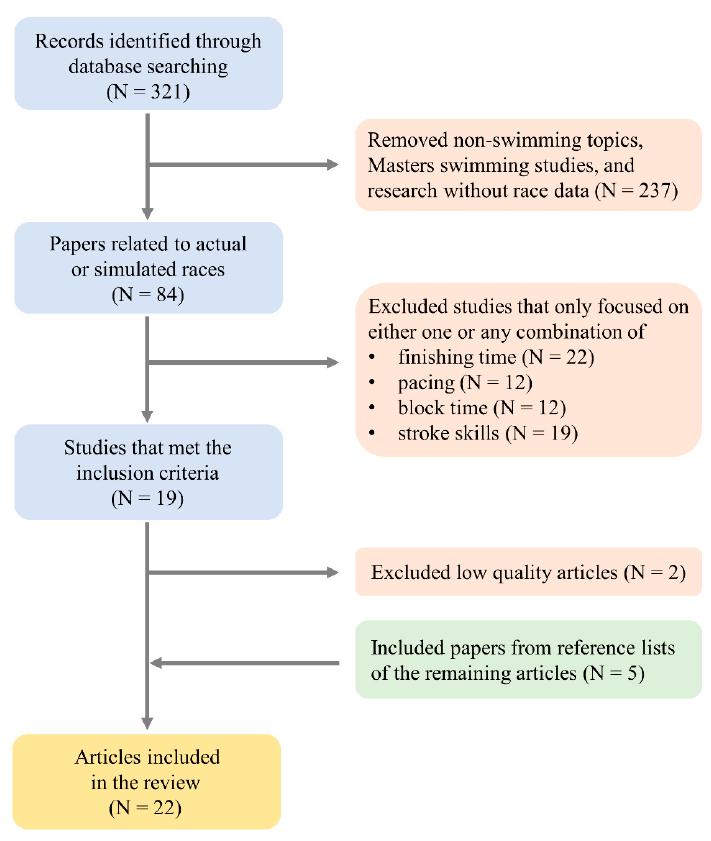
Figure 1. Flow chart summary of the study selection process.